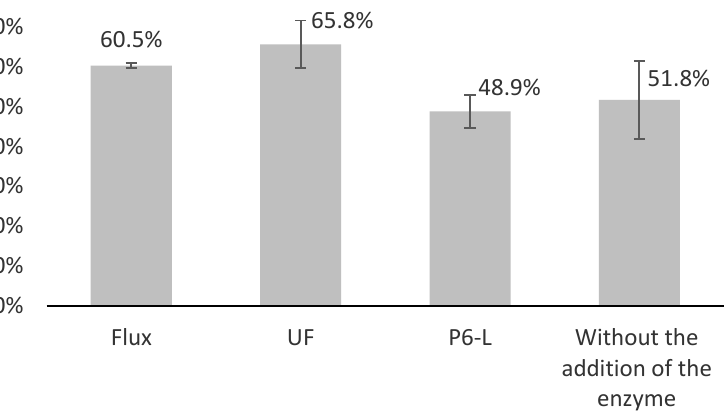
Figure 1. Juice yield after enzymatic treatment of ground hogweed with the use of enzyme prepa- rations.